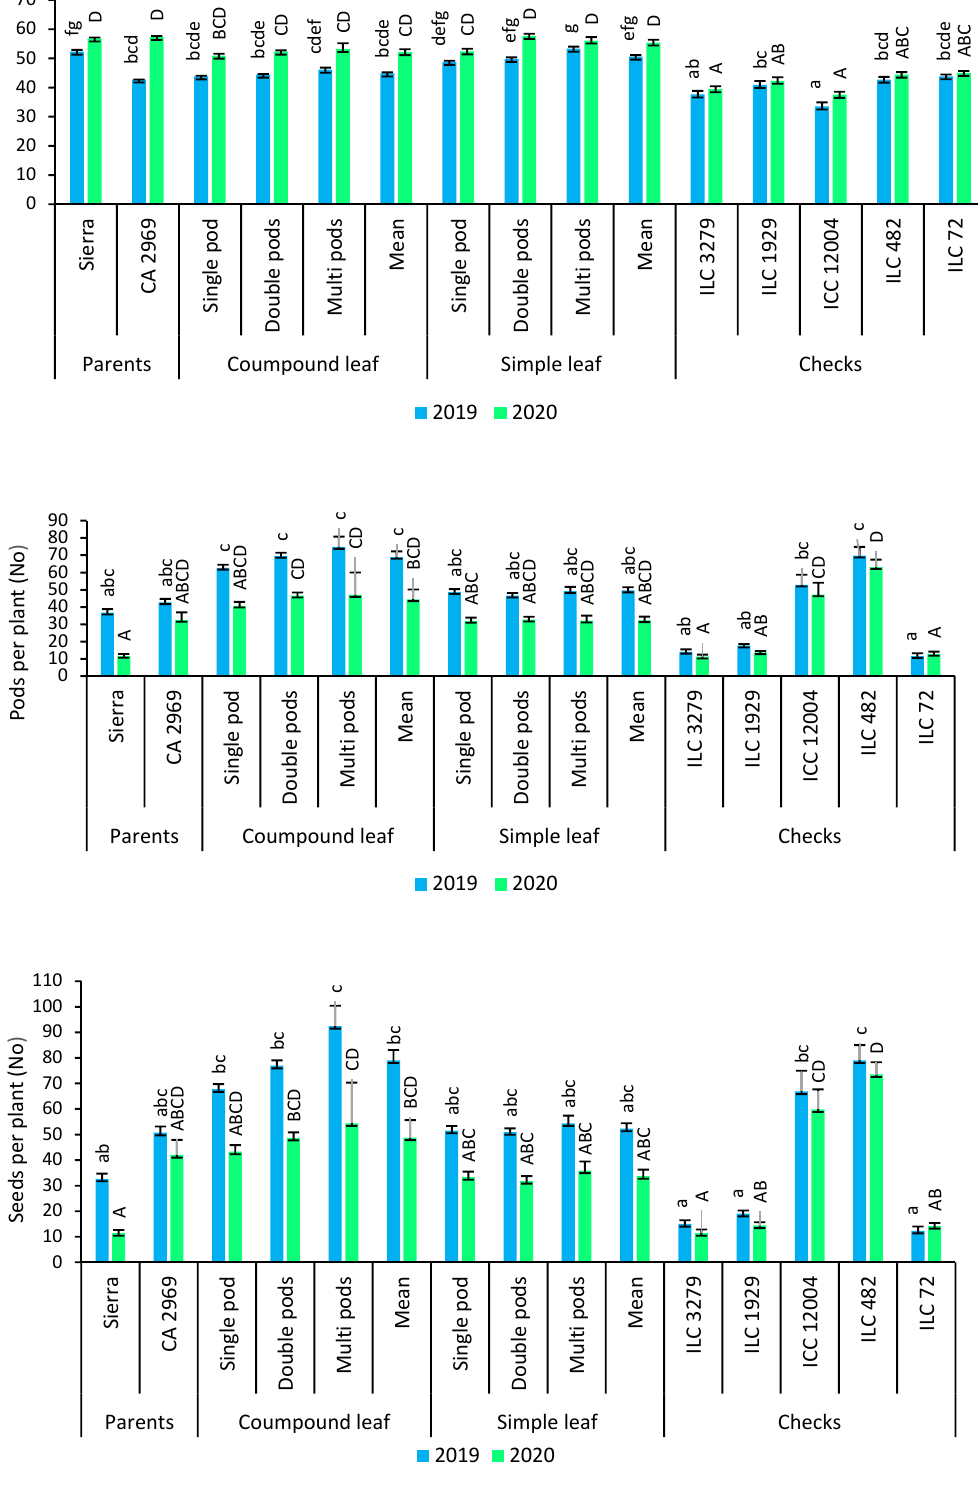
Figure 4. Comparison of compound-leafed versus simple-leafed and multi-podded versus double- podded and single-podded chickpeas with parents and checks for plant height, pods and seeds per plant. Different lowercase letters and uppercase letters represent the significant difference ( p ≤ 0.05) between the means for 2019 and 2020, respectively.